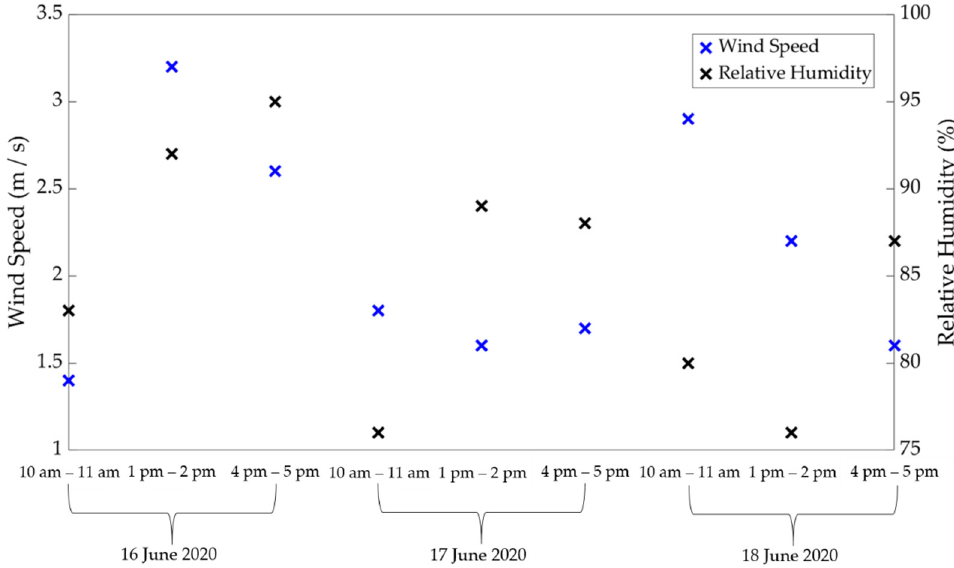
Figure 4. Wind speed and relative humidity measured in each hourly investigative period between